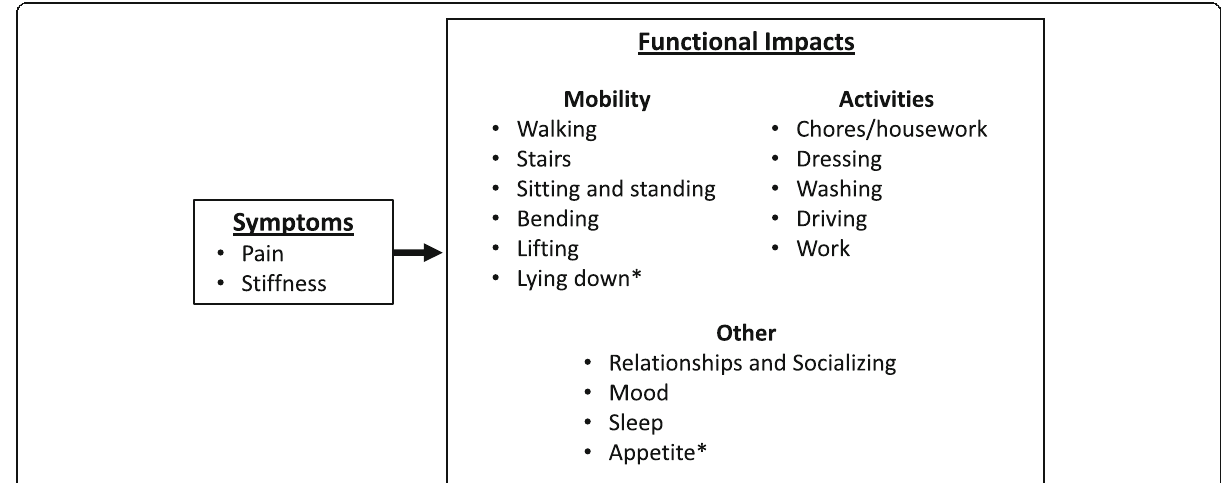
Fig. 1 Conceptual Model of CLBP from the Participant Perspective. CLBP – chronic low back pain. * These themes were identified as important during the cognitive debrief phase of the interview and were not spontaneously mentioned during concept